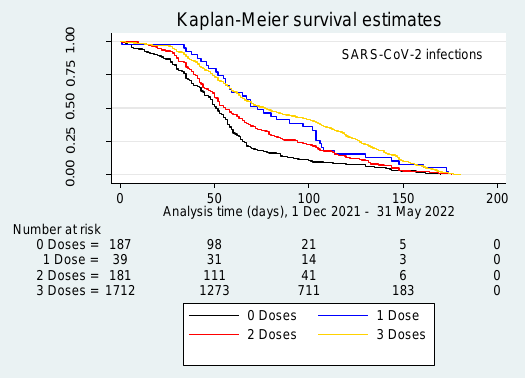
Figure 4. (Kaplan – Meier survival curve). SARS-CoV-2 primary infections ( N = 2130) occurred in healthcare workers (HCWs) of ASUGI from 1 December 2021 – 31 May 2022, by number of doses of COVID-19 vaccines received 7+ days (14+ days in case of only one dose) before infection. Number of HCWs at risk by number of doses of COVID-19 vaccine received.